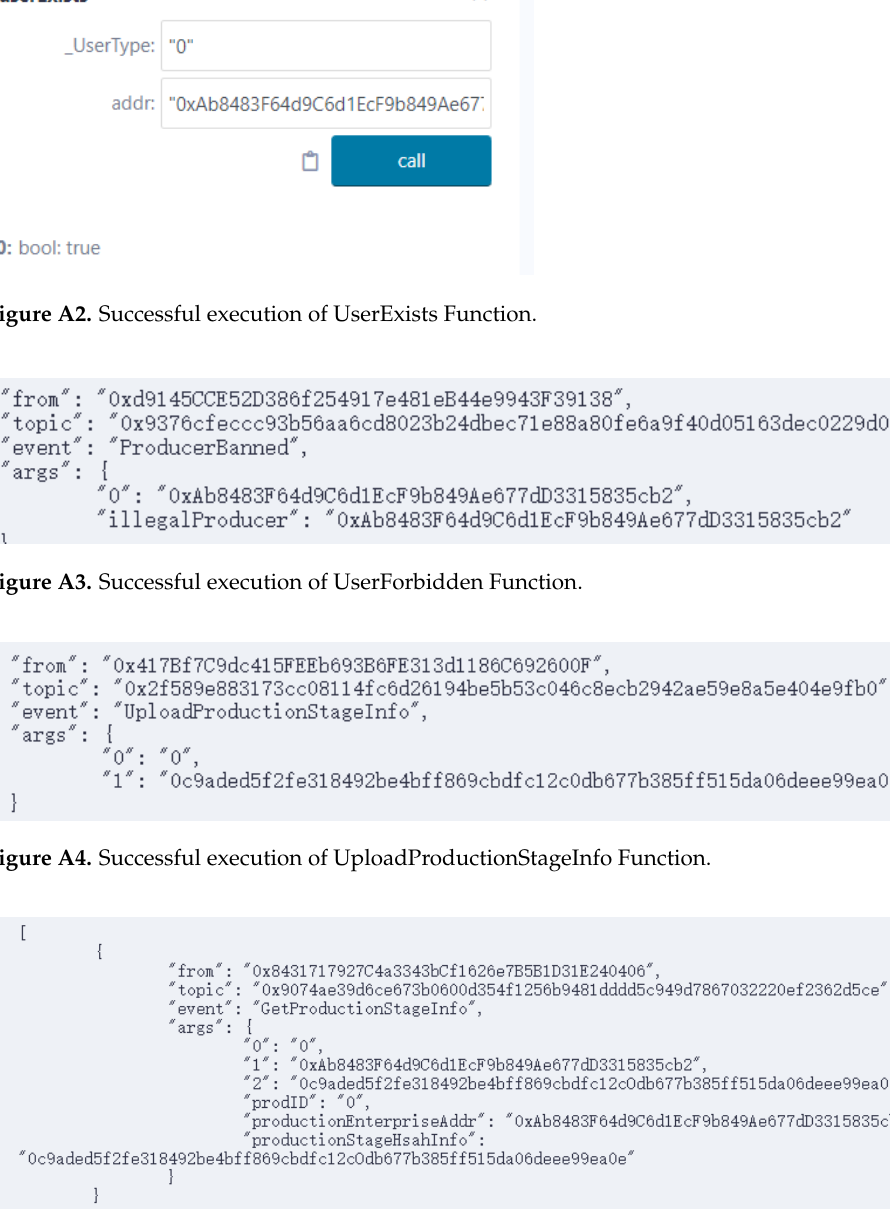
Figure A5. Successful execution of GetProductionStageInfo Function.